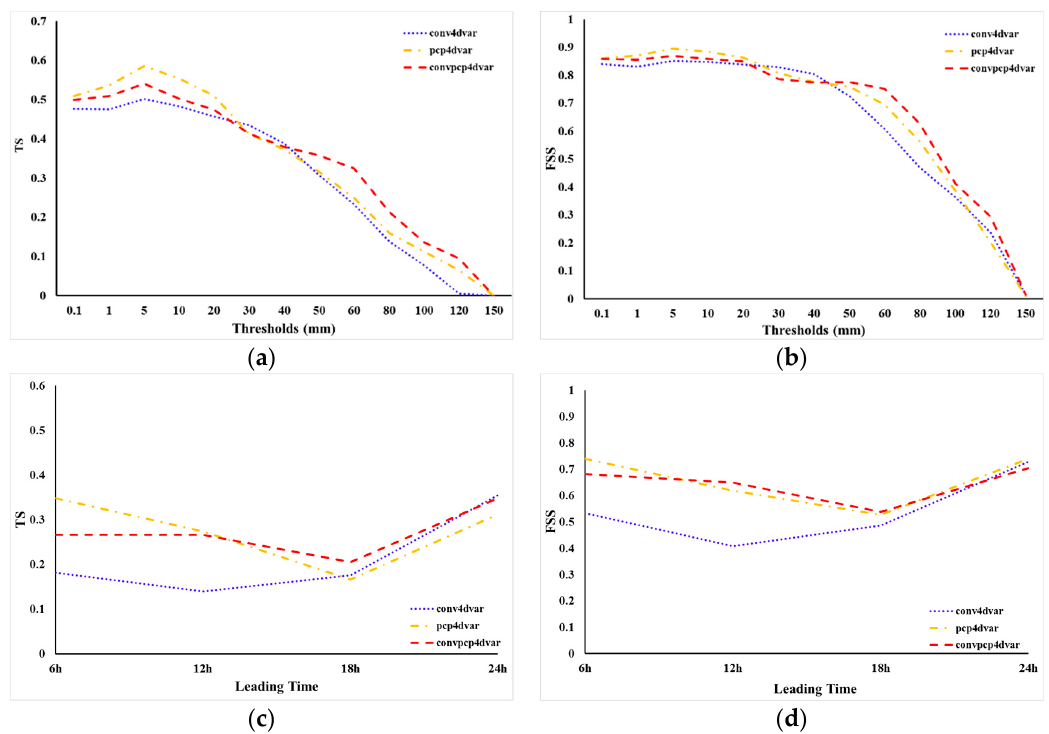
Figure 10. This is similar to Figure 7 but for sensitivity of rainfall forecast skill score to assimilated Figure10. observations.